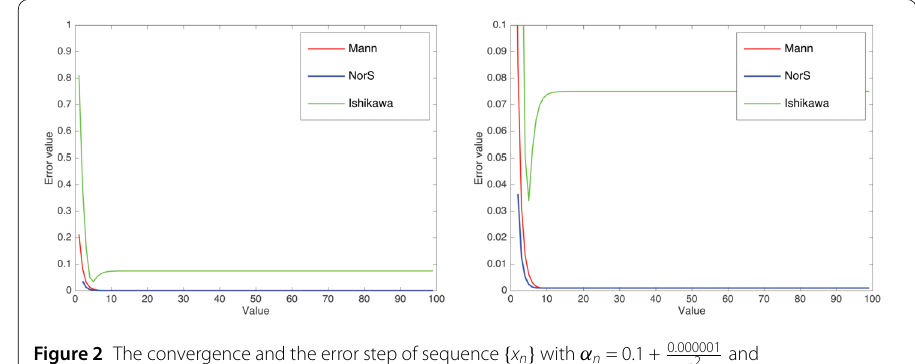
Figure 2 The convergence and the error step of sequence { x n } with α n = 0.1 + 0.000001 β n = 0.005 + 0.0000001 n